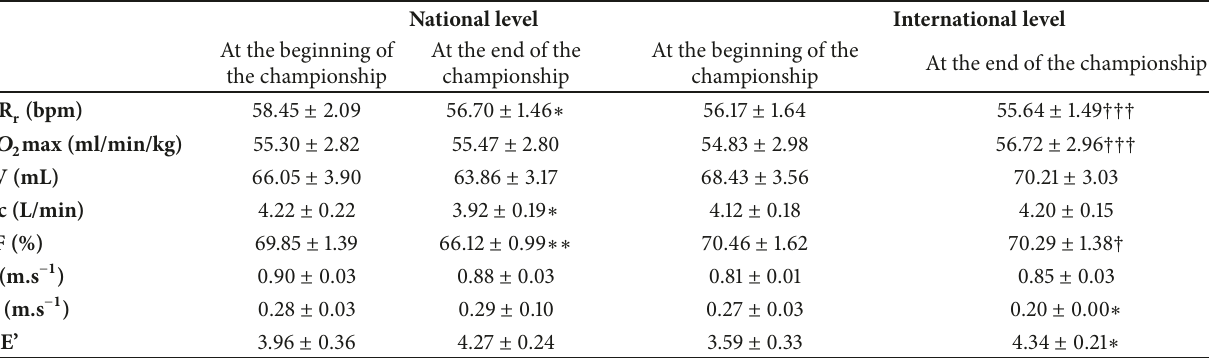
Table 4: Changes in the parameters of the left cardiac function of the studied soccer referees, between the beginning and the end of the Division 1 championship. N ational le v